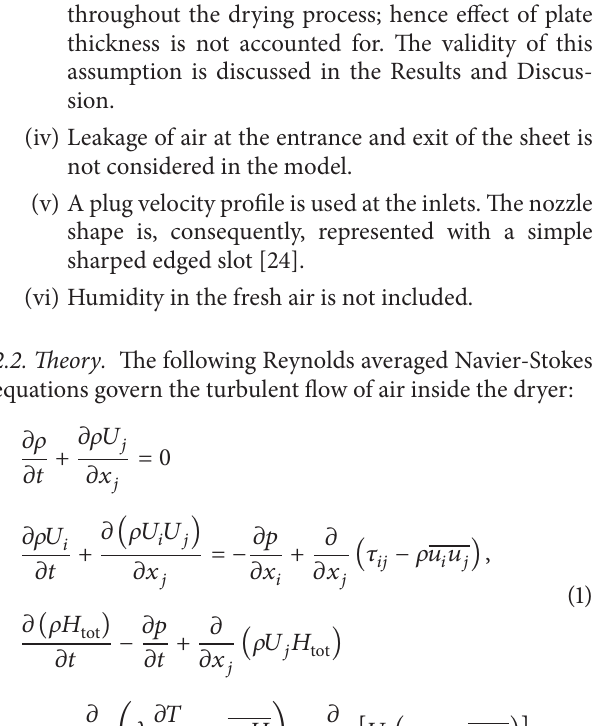
Table 1: Parameters of the reference